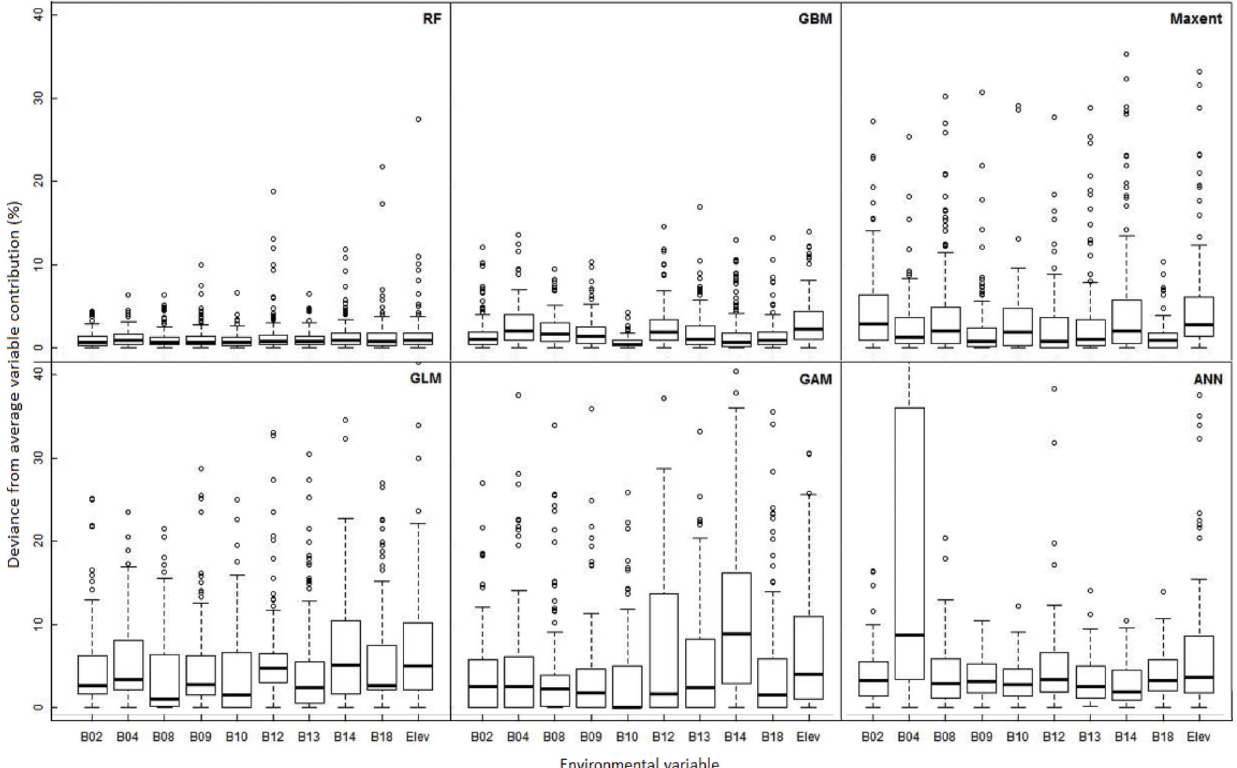
Figure 3. Consistency of the variables’ contribution to the model. Variability of the contribution of each environmental variable (i.e. deviance from the average variable contribution to the model) for each algorithm. In the Y axis higher deviance represents a lower consistency in the contribution values given by the algorithm to the different variables across runs. The values for variable ‘‘B04’’ in the ANN algorithm go to 80% and other variables present outliers going beyond the 40%, however, for plotting convenience we show only the deviance up to the 40%. See Table 1 and Tables S8 and S9 for further statistical information.